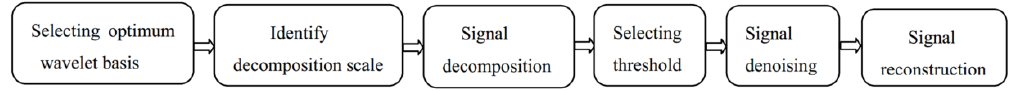
Figure 2. Flow chart of WT. This figure was obtained from reference [39].